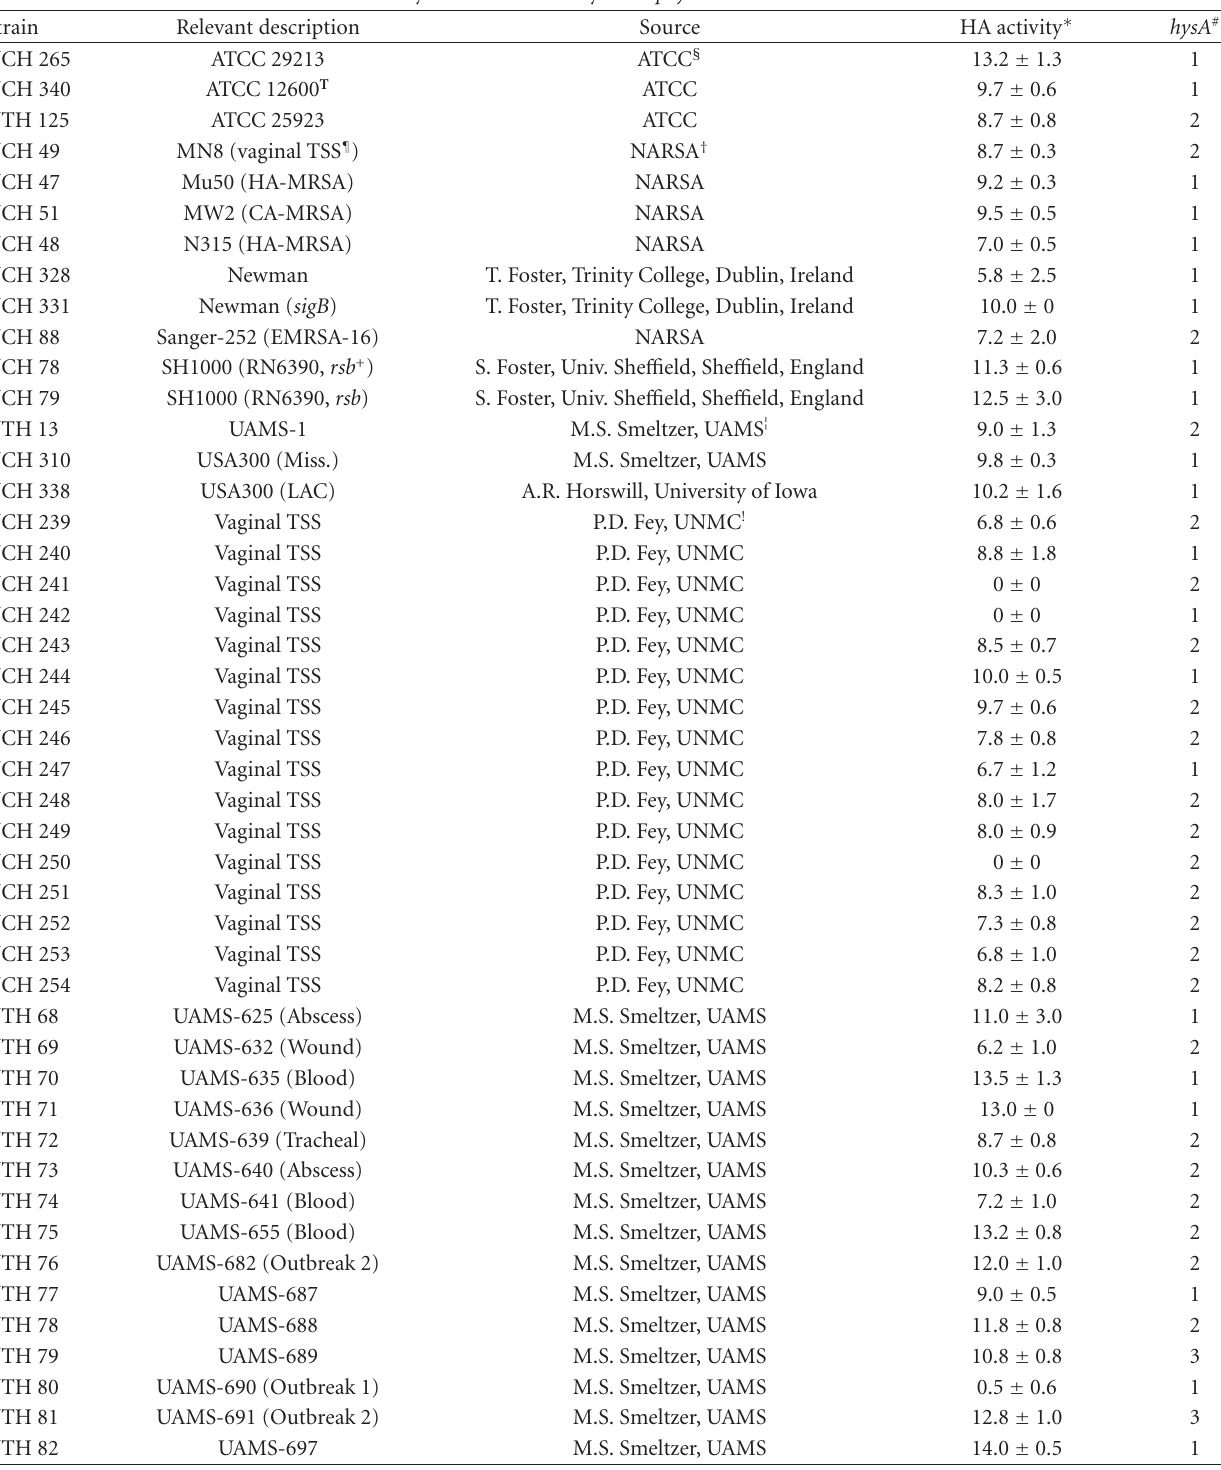
∗ Values represent the mean diameter in millimeters ± the standard deviation of three independent determinations. # Values represent the number of chemiluminescent bands detected when hybridized with a hysA specific probe. § American Type Culture Collection (ATCC), Manassas, Va. T Type strain ¶ Toxic shock syndrome. † Network for Antimicrobial Resistant Staphylococcus aureus